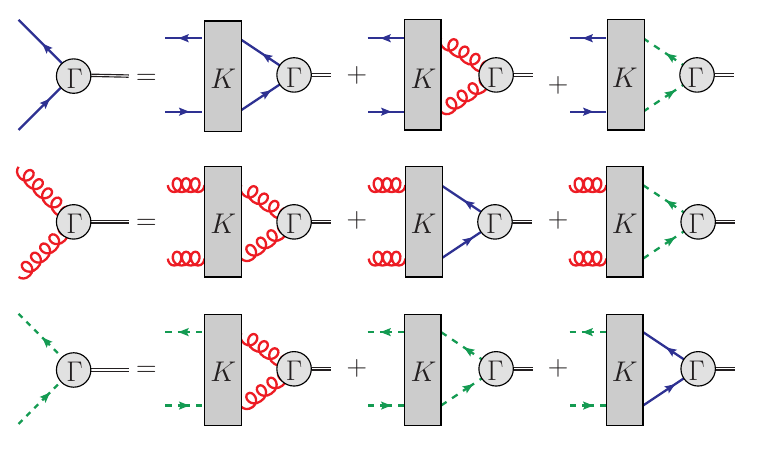
Figure 1. Two-body bound state equations of QCD. The blue continuous / red wiggly / green dashed lines are quark / gluon / ghost propagators. Γ are Bethe-Salpeter amplitudes and K the scattering kernels. For pure Yang-Mills theory, diagrams with quarks do not